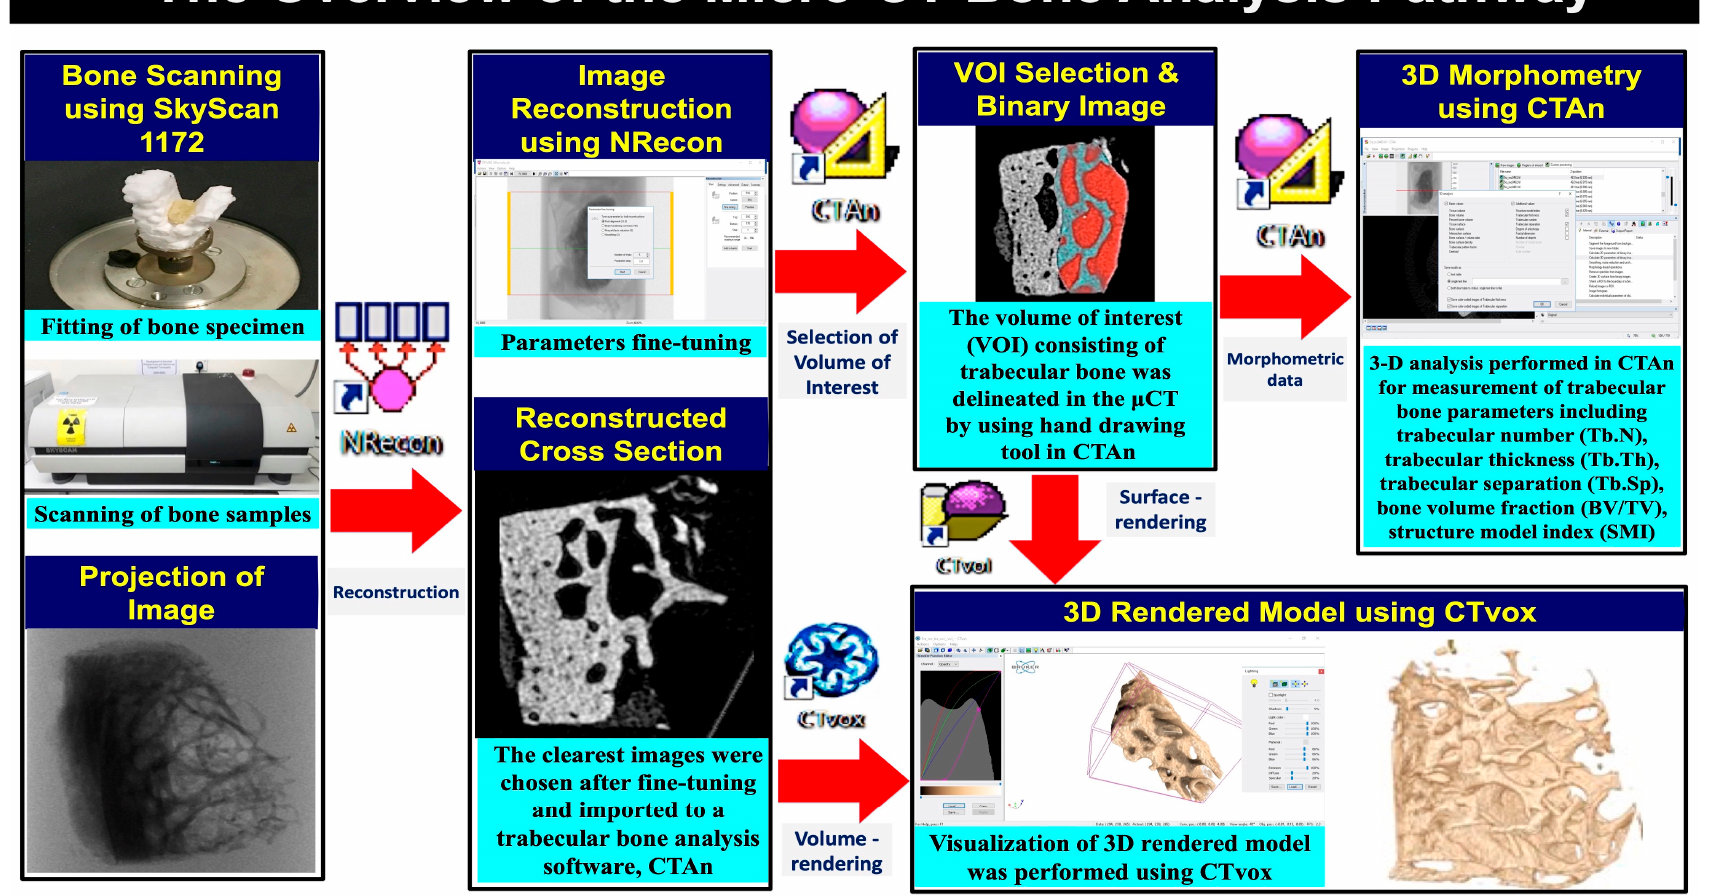
Figure 2. An overview of the micro-CT bone analysis process. All the steps were supported by SkyScan software. The steps for the micro-CT bone analysis pathway were bone scanning using SkyScan 1172, image reconstruction using NRecon, the volume of interest (VOI) selection and 3D morphometry acquisitions using CTAn. Visualization of the 3D rendered model was performed using CTvox or CTvol.